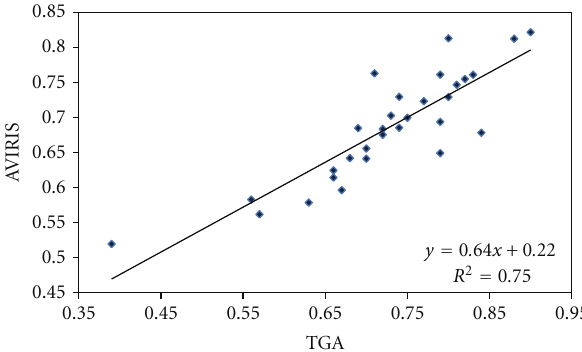
Figure 4: Regression of AVRIS data on TGA values obtained in laboratory.